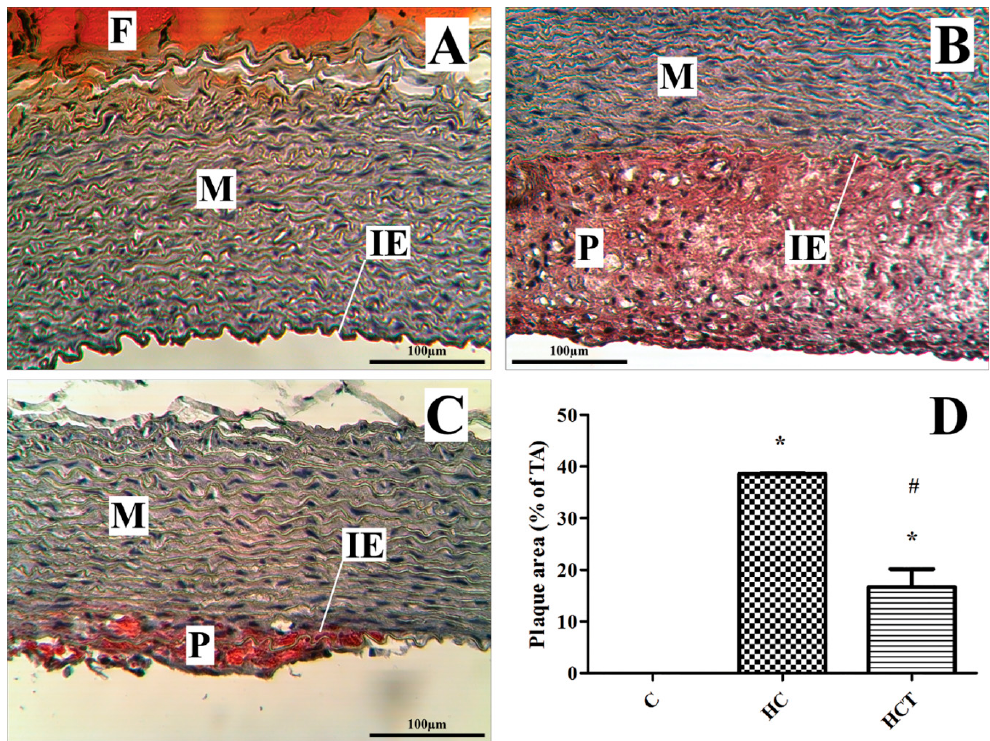
Figure 4. Aortic histologic analysis. Histological sections of aortas from three groups of rabbits stained with hematoxylin-oil red O ( A – C , magnification 25×). Bright red-stained lipid shows atherosclerotic plaques in the HC ( B ) and HCT groups ( C ). Internal elastic lamina is shown as IE; M, media; P, atherosclerotic plaques; and F, adventitial fatty tissue stained with oil red O. Comparison of plaque area in the three groups, expressed as a percentage of the total area ( D ). * p < 0.05 for comparison with the control group outcomes; # p < 0.05 for comparison with the HC group outcomes.